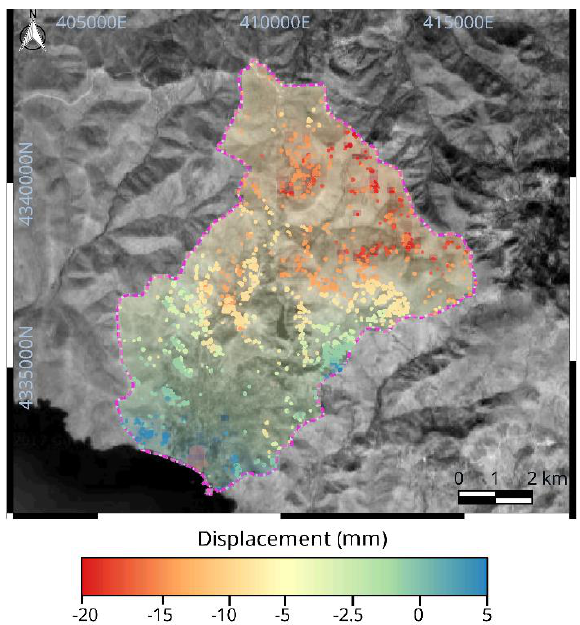
Figure 4. Cumulative deformation from October 2014 to May 2016. Total deformation at the SBAS point were interpolated on a regular spatial grid by means of Inverse Distance Weighting interpolation. The background image is the identical to figure 4